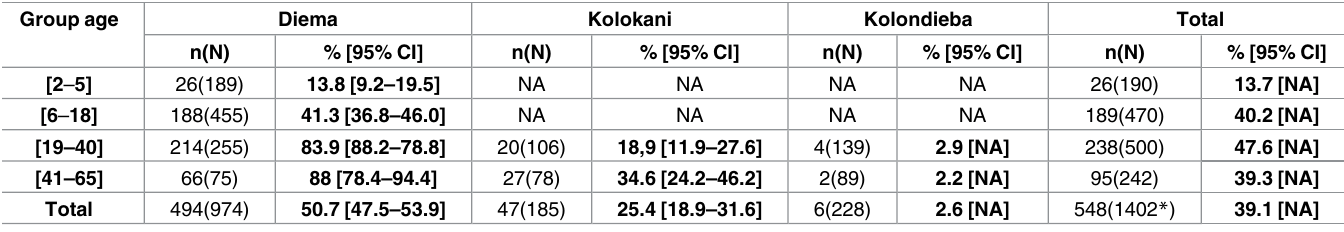
Table 2. Prevalence of LST positivity by age group and by study districts. Group